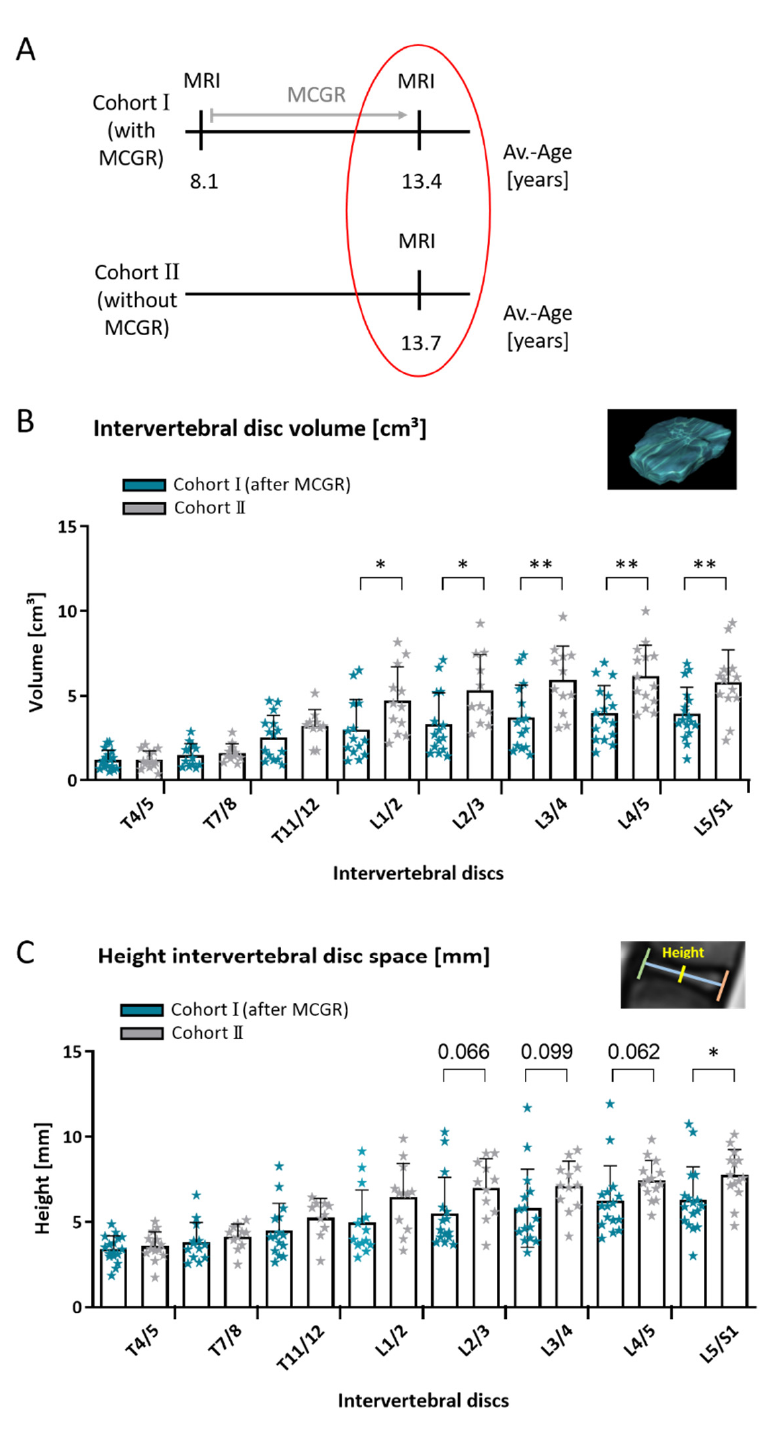
Figure 6. Intervertebral disc volume in age- and disease-matched children with and without MCGR. Comparing age- and disease-matched children with and without prior MCGR ( A ). Untreated children had significantly higher lumbar disc volumes in comparison to MCGR-treated children ( B ). Note the trend towards increased height of intervertebral disc space in untreated children ( C ). ( B ) and ( C ) Unpaired t -test; mean +/ − SD; n = 17/14 (T4/5), 13/11 (T7/8), 15/10 (T11/12), 14/12 (L1/2), 15/11 (L2/3), 15/12 (L3/4), 16/14 (L4/5) and 17/14 (L5/S1) with prior MCGR (Cohort I after MCGR) and without prior MCGR (Cohort II) respectively; statistical level of significance p < 0.05 (*), p < 0.01 (**); for t -test results close to significance, p -values are given above the corresponding